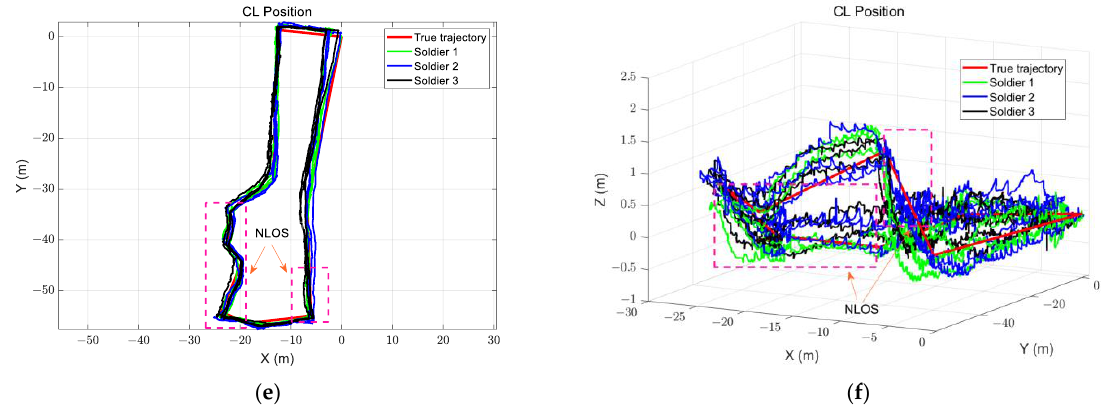
Figure 8. Trajectories with different algorithms. ( a ) Inertial navigation trajectories without CL algorithm (2D); ( b ) inertial navigation trajectories without CL algorithm (3D); ( c ) trajectories with CL algorithm (without dealing with NLOS errors, 2D); ( d ) trajectories with CL algorithm (without dealing with NLOS errors, 3D); ( e ) trajectories with CL algorithm (dealing with NLOS errors, 2D); ( f ) trajectories with CL algorithm (dealing with NLOS errors, 3D).